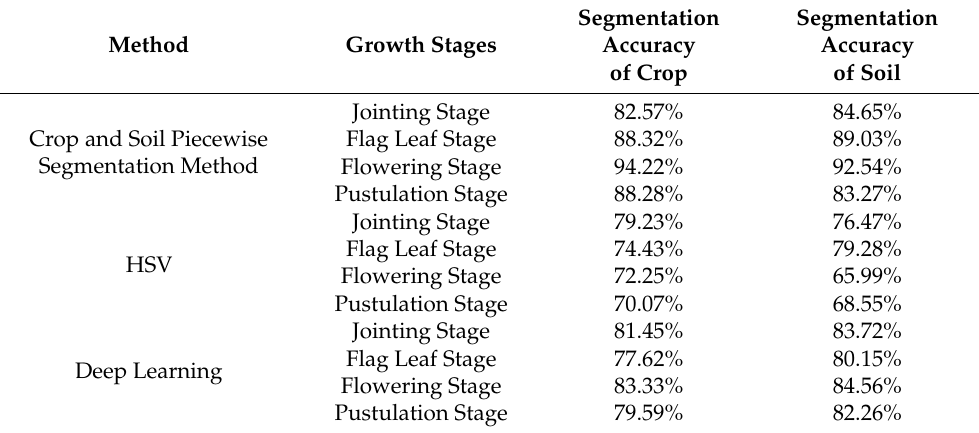
Table 2. The comparison of three segmentation methods for crop and